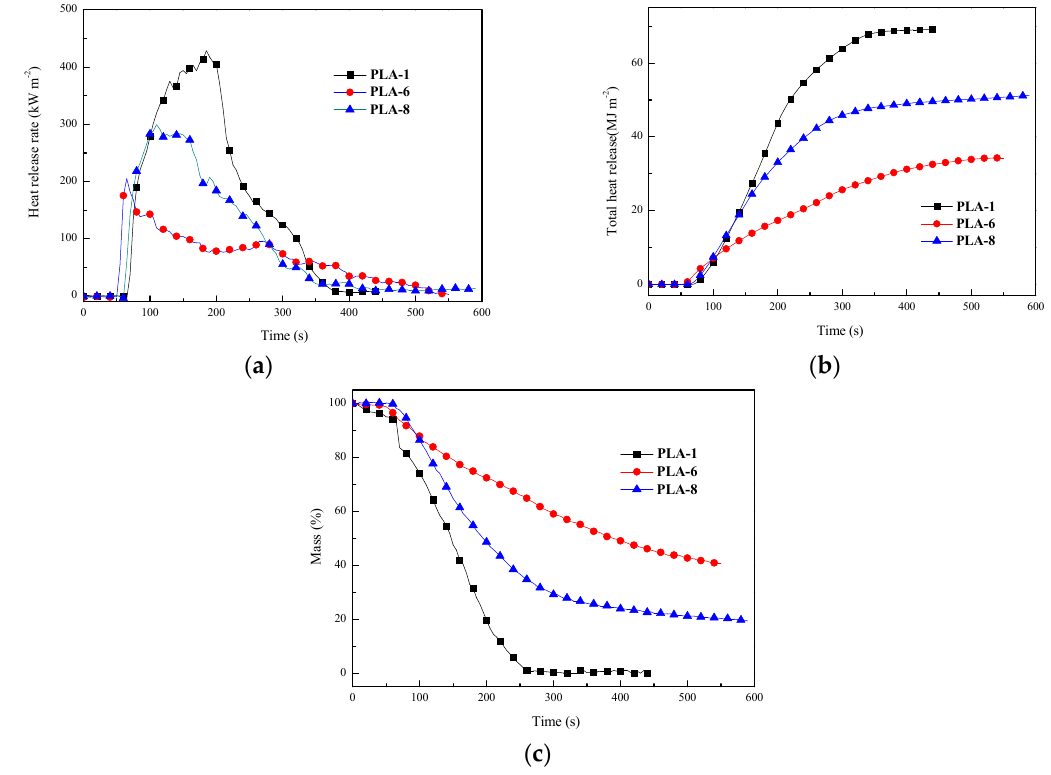
Figure 4. ( a ) HRR curves; ( b ) THR curves; ( c ) MLR curves of PLA and PLA composites. Table 4. Cone calorimeter testing data of PLA and PLA composites.